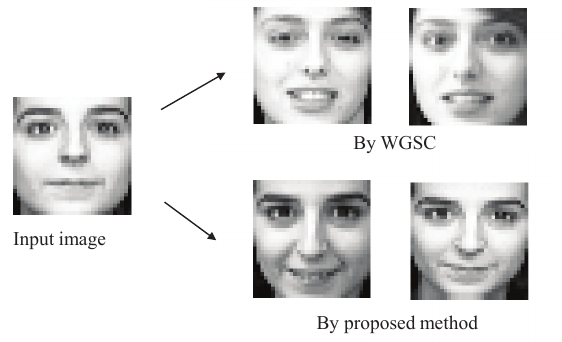
Figure 3. An example of results by WGSC and proposed